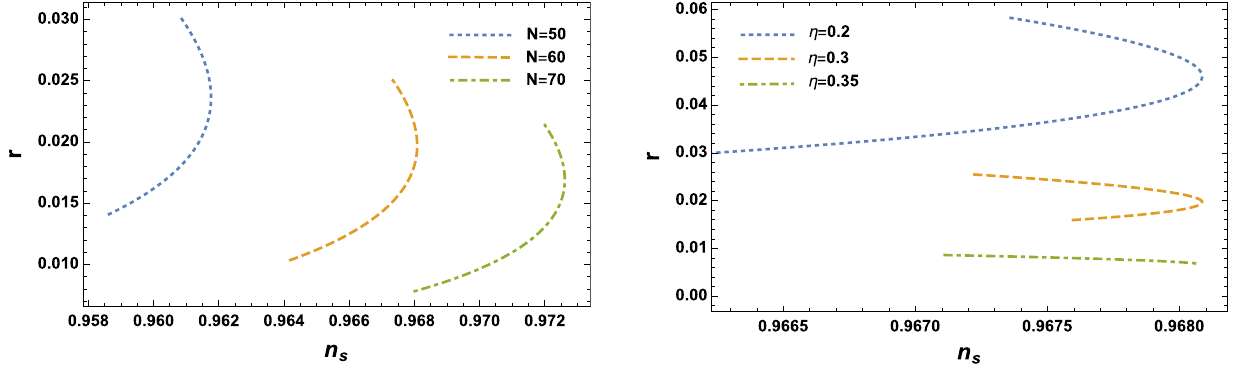
Fig. 9 n s vs r for φ 0 in the interval 2 × 10 − 4 M p ≤ φ 0 ≤ 2 × 10 − 3 M p for N = 50 , 60 , 70, η = 0 . 3 and β = 10 9 . All curves fall well inside the region favored by latest observations